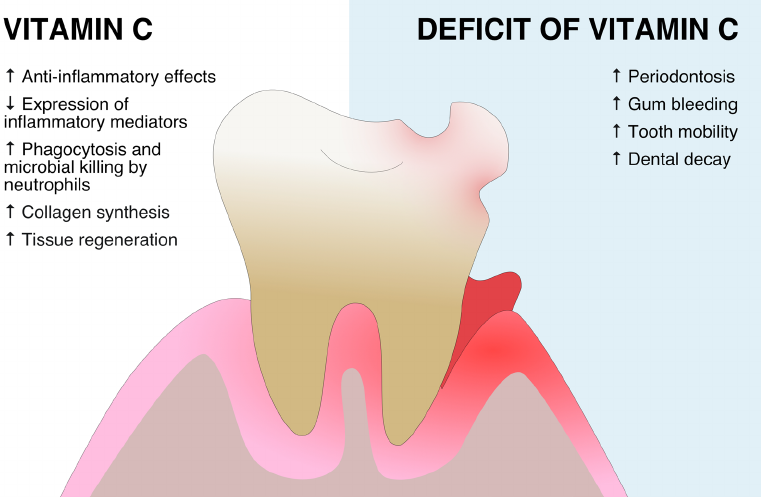
Figure 1. The role of vitamin C and possible effects of its deficiency on the periodontal tissue. Table 1. A summary of the most important studies on the effects of VitC on periodontal health.